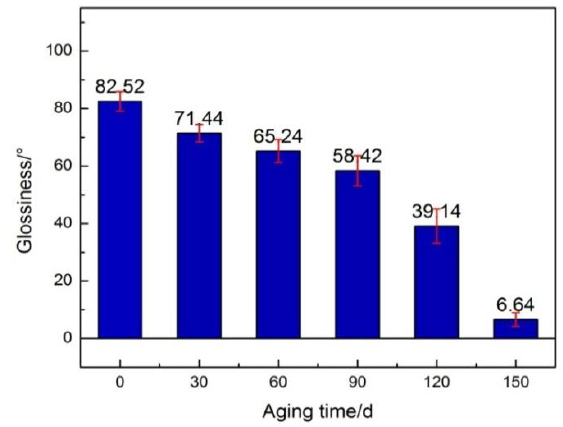
Figure 3. Change in gloss with aging time.